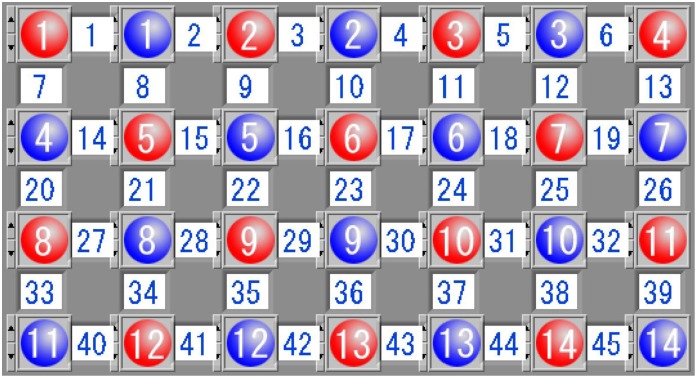
Fourteen pairs of probes comprised 45 channels.The red and blue numbers represent emission and detector probes, respectively. The bilateral DLPFC and the orbitoprefrontal cortex are covered by these channels.